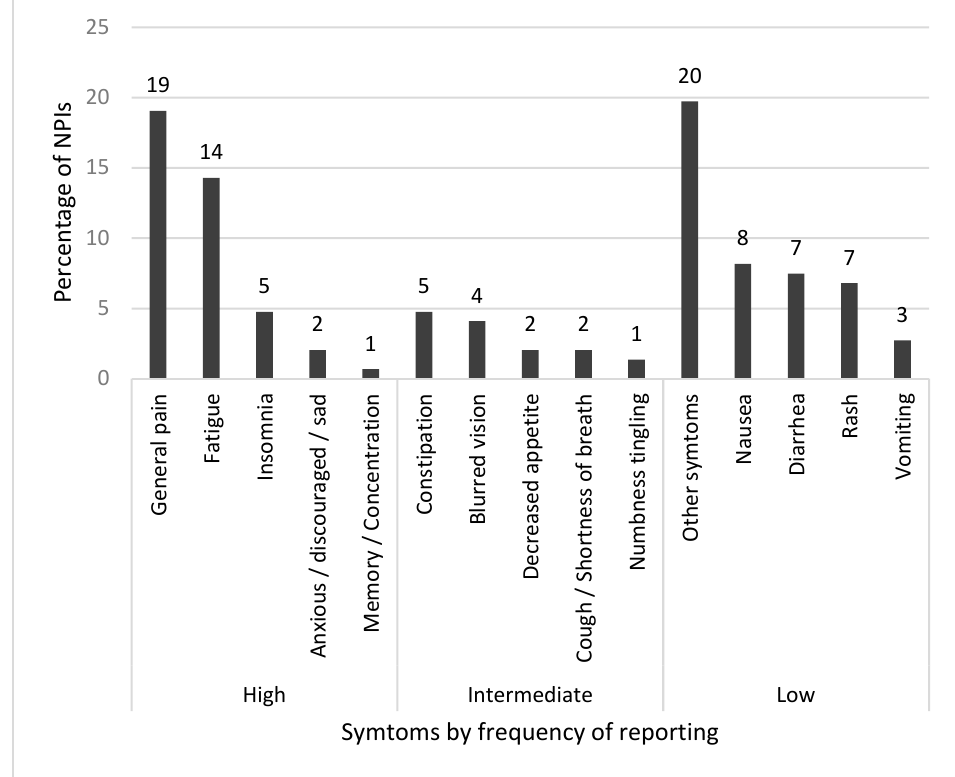
Figure 4. Nurse and pharmacist intervention (NPI) distribution per symptom and per symptom reporting frequency. Caption: High frequency: symptom reported ≥ 200 times during the study period; intermediate frequency: symptom reported 100–199 times during the study period; low frequency: symptom reported < 100 times during the study period.